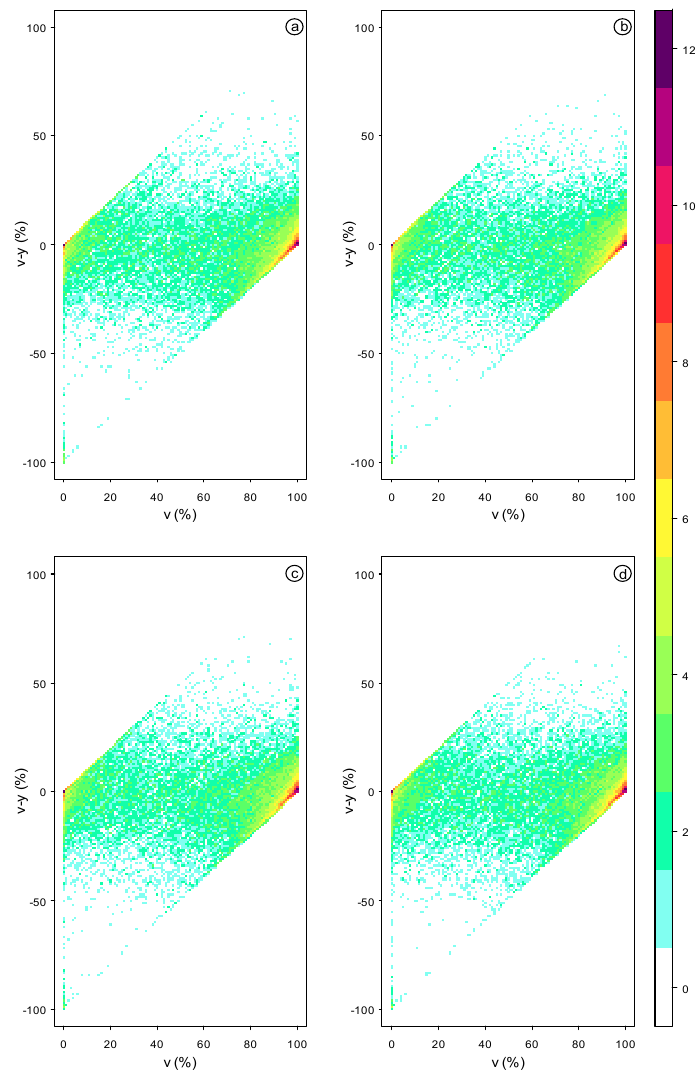
Figure 6. Percent tree cover estimation errors ( v – y ) plotted as a function of percent tree cover ( v ) where y is a regression tree estimated value and v is the corresponding validation data value, considering all 67,837 validation reference pixels; the plot colors show the frequency of occurrence of similar error values with a log2 scale. The results are shown for the percent tree cover maps derived using 8% training per tree and 50 multi-temporal metrics extracted from ( a ) top of atmosphere ARD (TOA ARD); ( b ) atmospherically corrected ARD (SRF ARD); ( c ) BRDF adjusted atmospherically corrected ARD (NBAR SRF ARD); and ( d ) weekly composited BRDF adjusted atmospherically corrected ARD (NBAR SRF